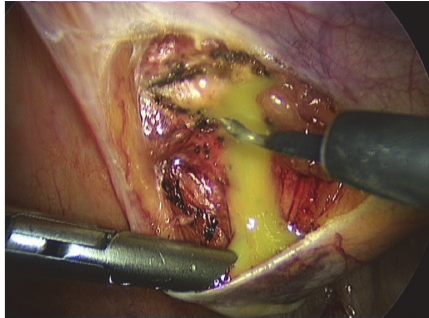
Figure 2: Opening of the cyst revealed approximately 600cc of green-yellow viscous fluid.